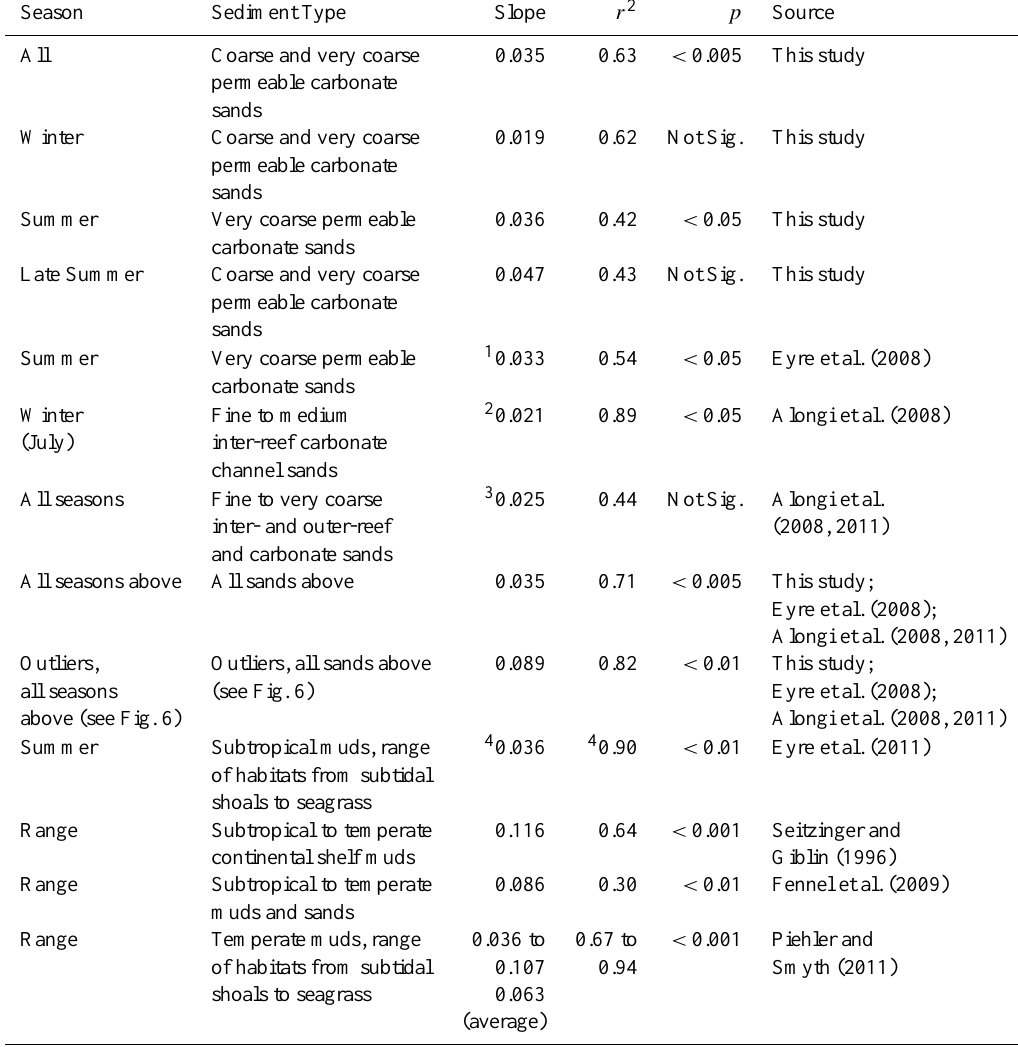
Table 5. Slope of the relationship between benthic oxygen respiration (µmol O 2 m − 2 h − 1 ) and dark N 2 efflux (µmol N 2 -Nm − 2 h − 1 ) . Regressions were forced through zero as there would be no N 2 efflux when respiration equals zero and to allow comparisons with previous studies. Outliers were removed from all regressions (see